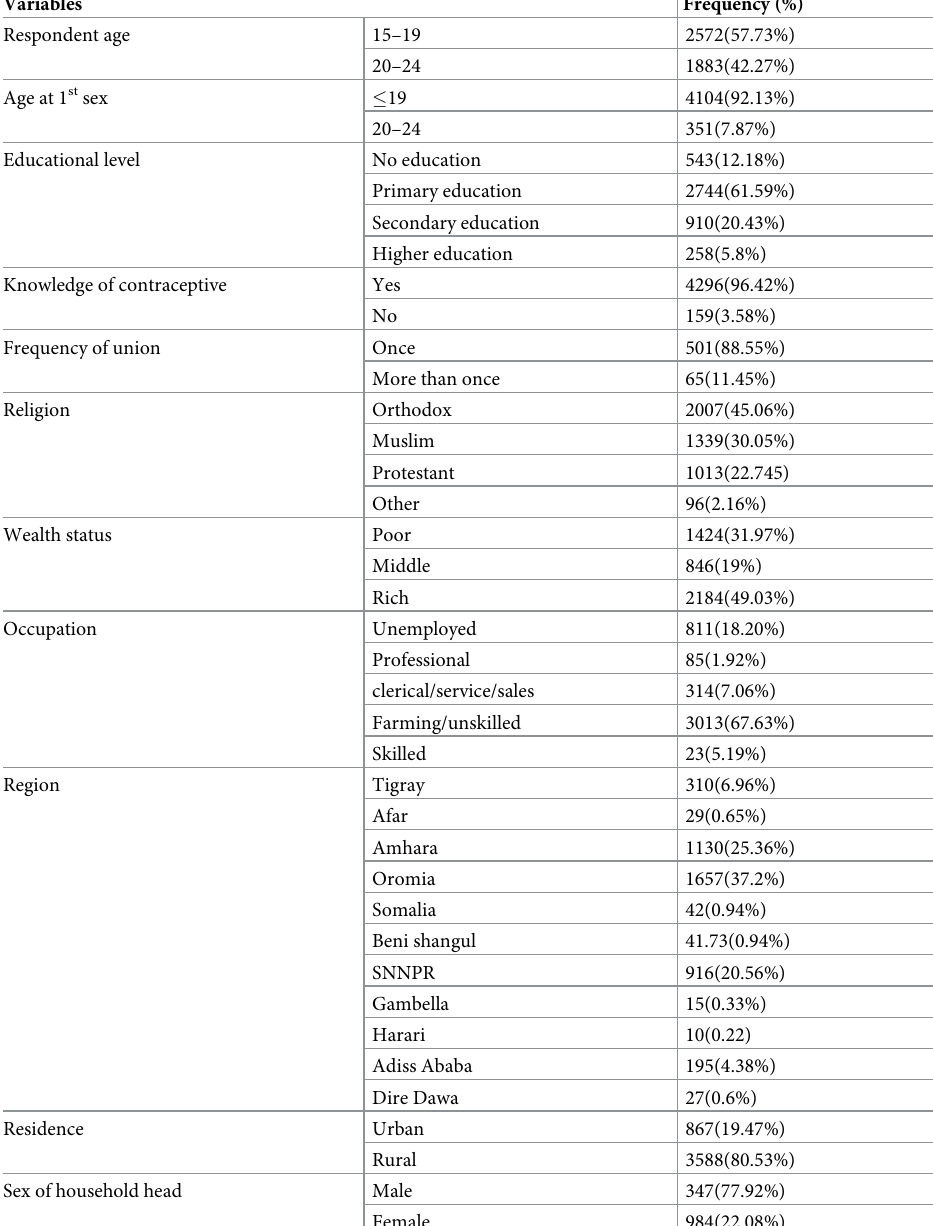
Table 2. Sociodemographic characteristics of the